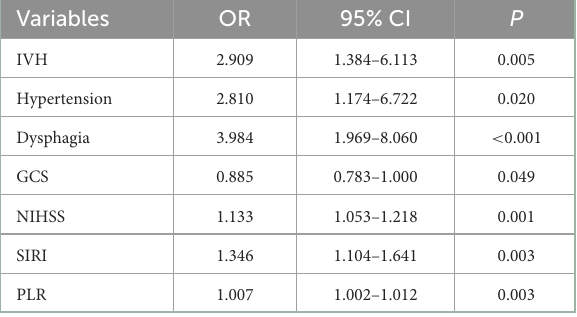
TABLE 3 Multivariate logistic regression analysis of the screening predictors of SAP after